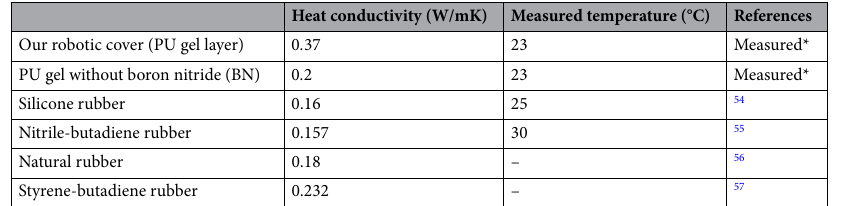
Table 3. Heat conductivity of our robotic cover compared with other soft materials. *The parameters of our cover are measured by the hot disk method (TPA-501, Kyoto Electronics Manuf. Co., LTD, Japan).